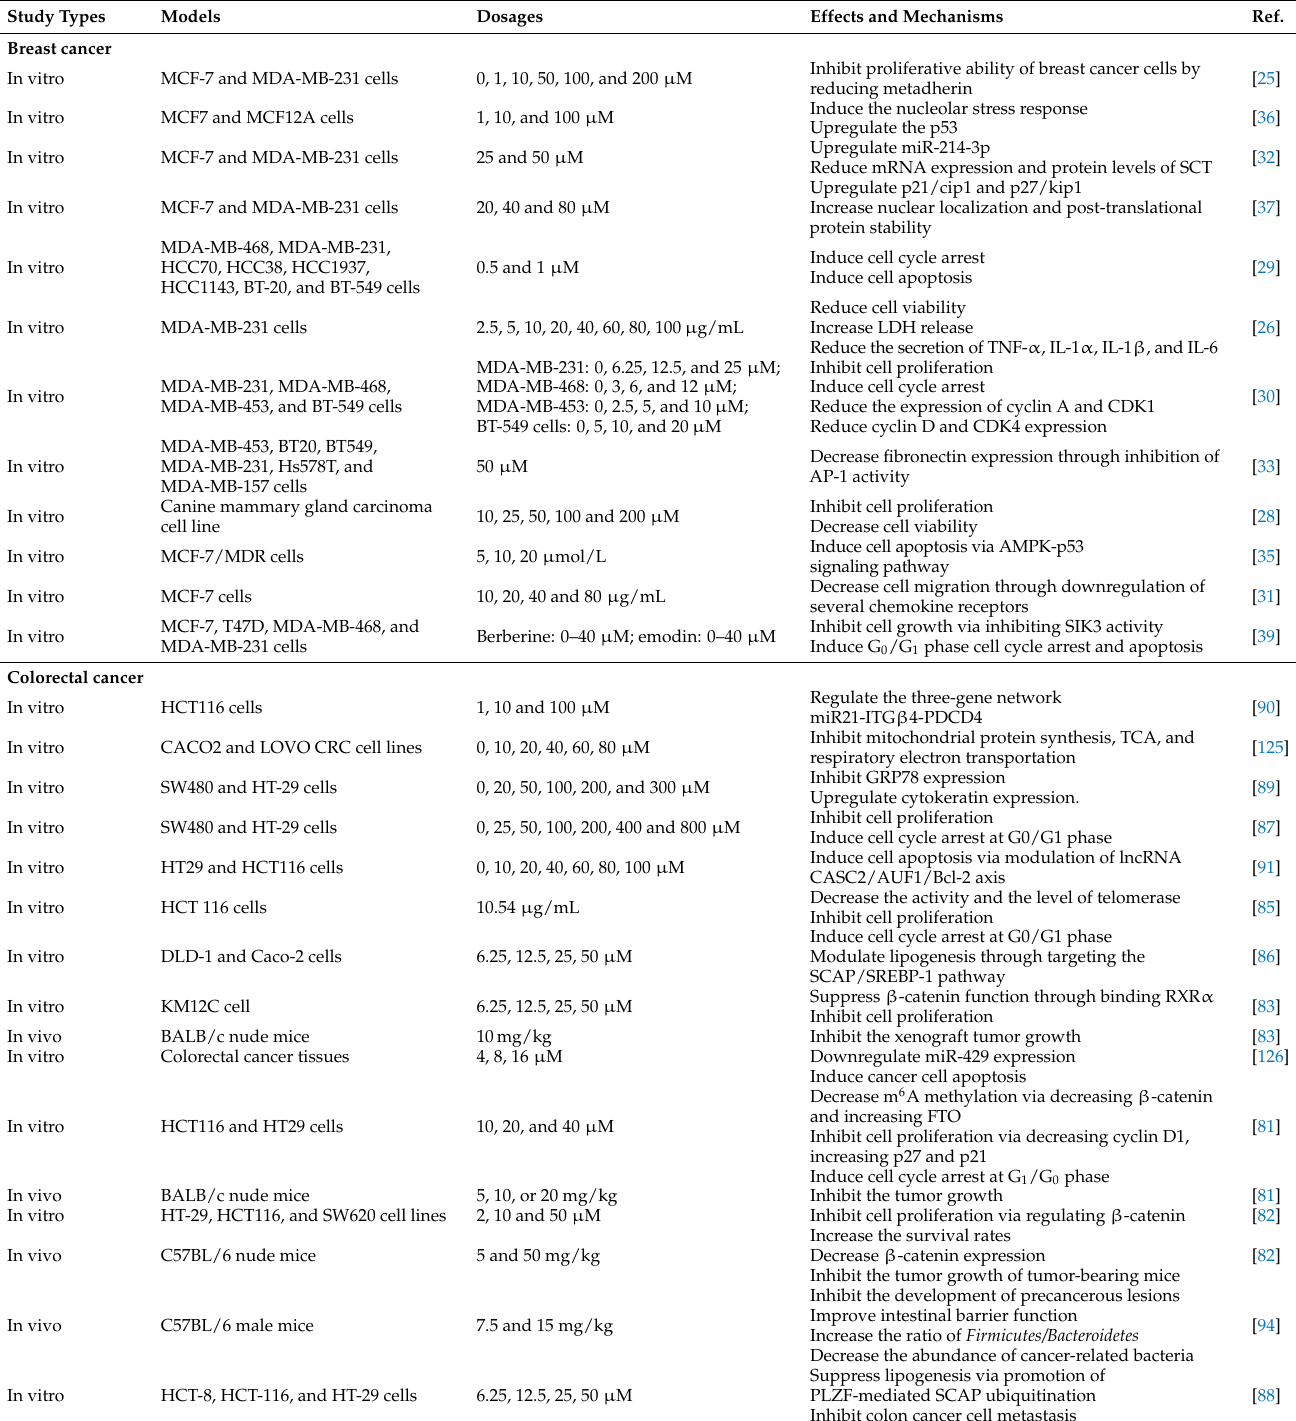
Table 1. Effects and mechanisms of berberine on several